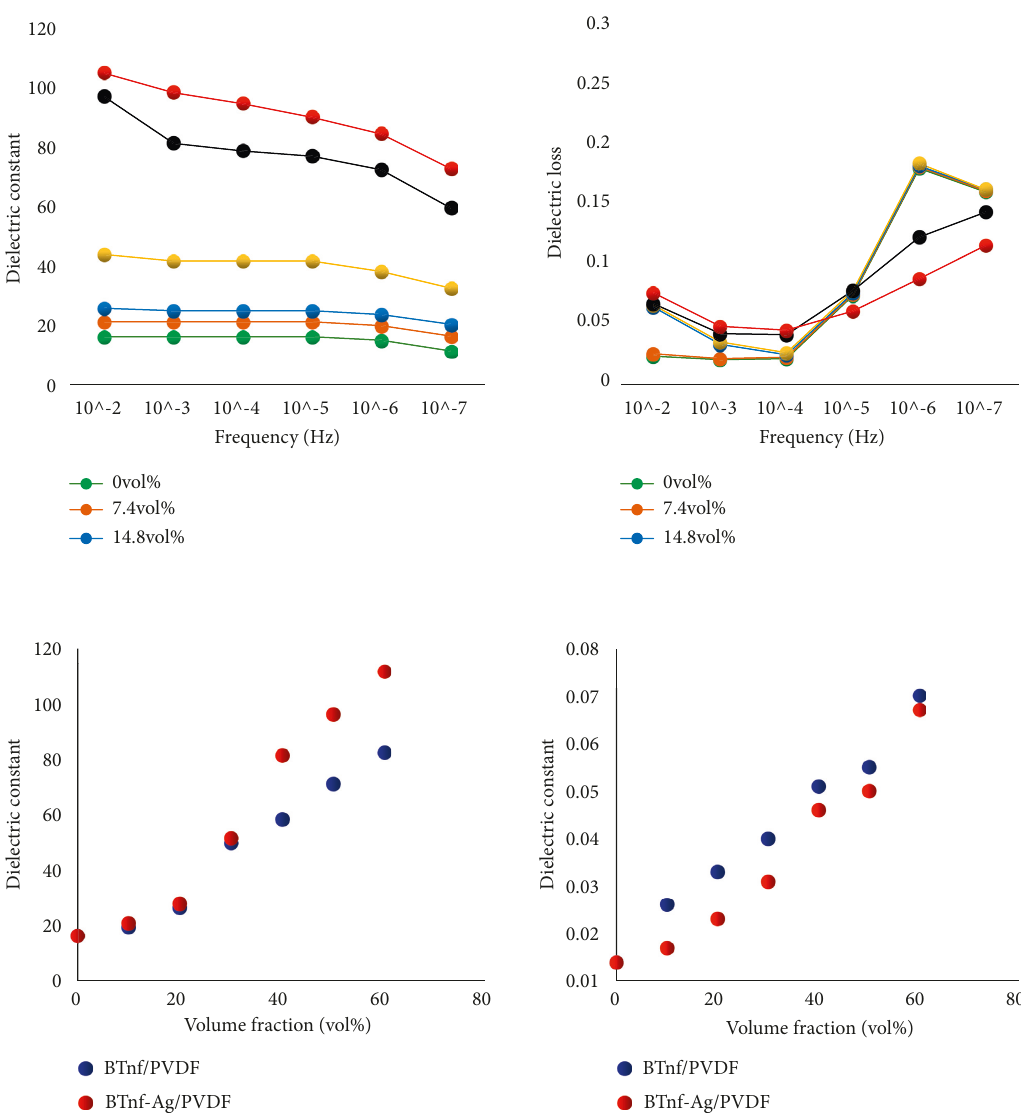
Figure 6: Frequency dependence of the dielectric constant and the dielectric loss of PVDF nanocomposites with different contents of BTnf- Ag and